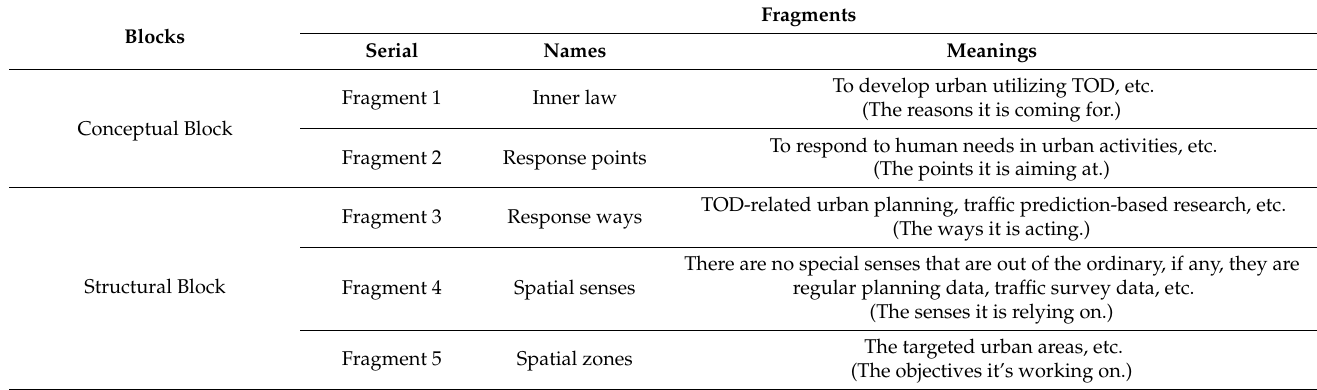
Figure 9. The logic expression from the reconstructed chains to the DNA Subchain β .